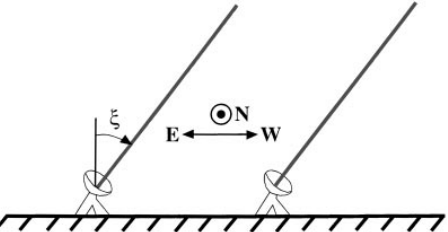
Fig. 5. Schematic view from the north of two elements of the array. The sine of the angle, (cid:110) ; is the westward component of the line of